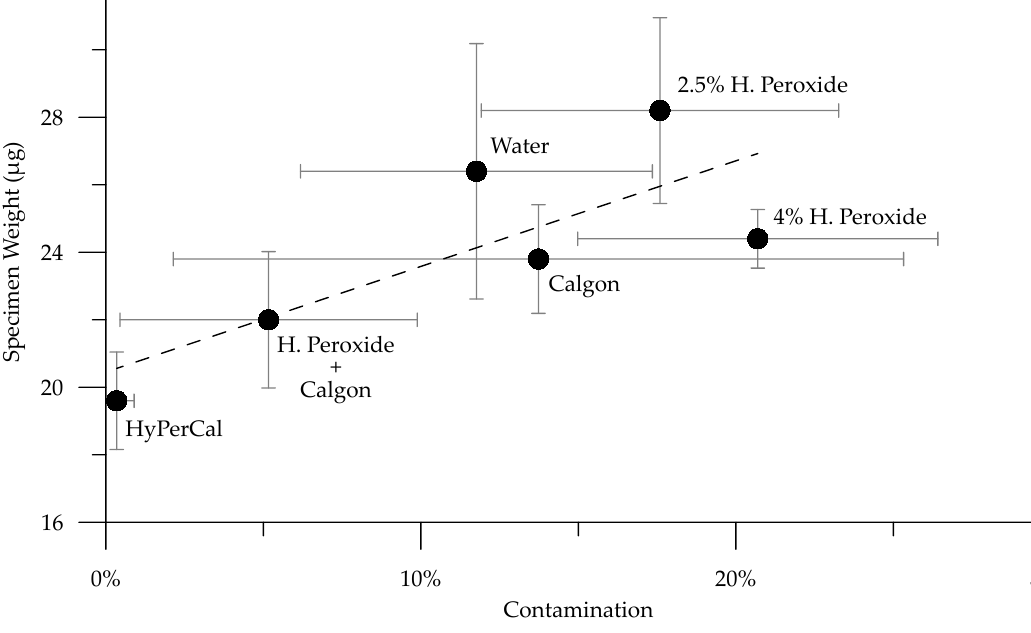
Figure 4. Plot of G. ruber albus s.s. shell weights after treatment with the di ff erent cleaning methods against their contamination as per volume